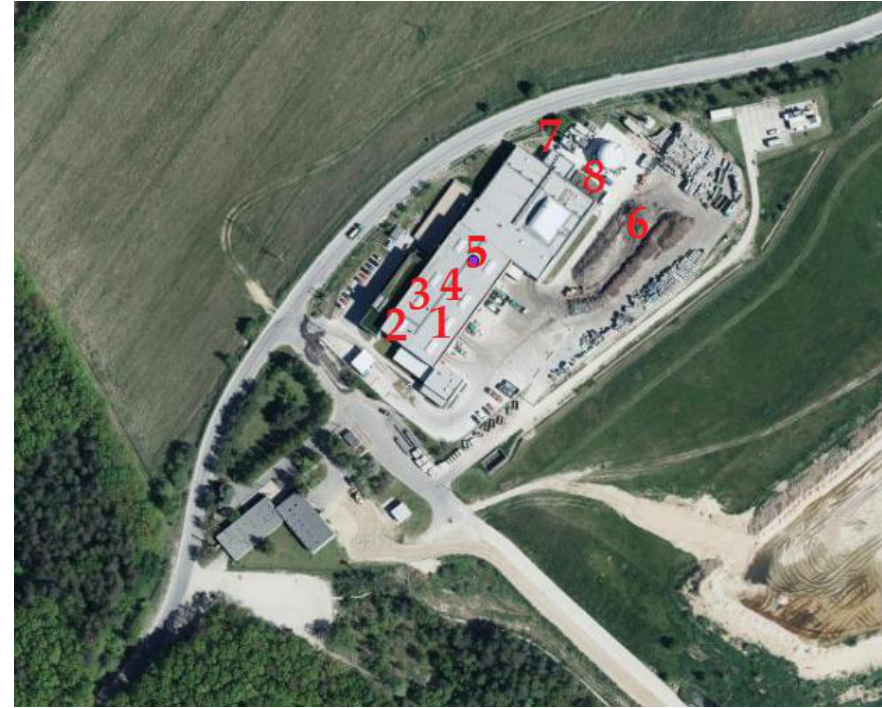
Figure 3. Measurement points locations at biogas plant in Wólka Rokicka.